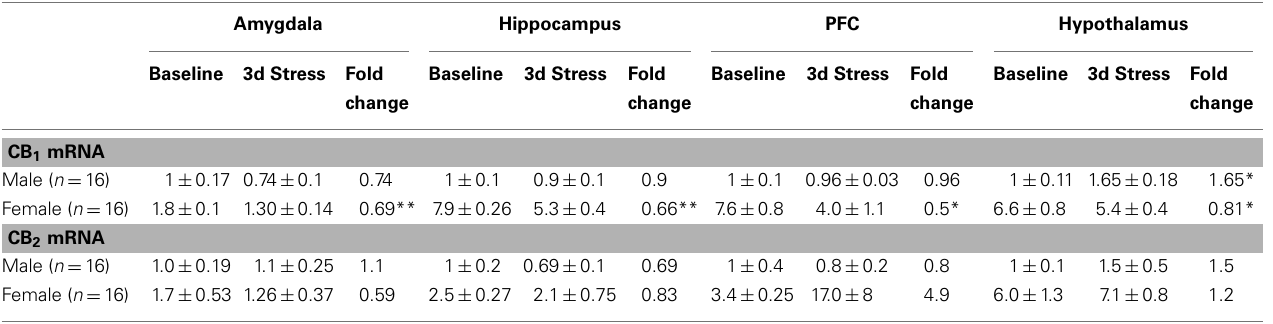
The baseline mRNA level of control male group in each region was used as the arbitrary reference ( = 1) for the males and females. *p < 0.05; **p < 0.01, control vs. stress within sex